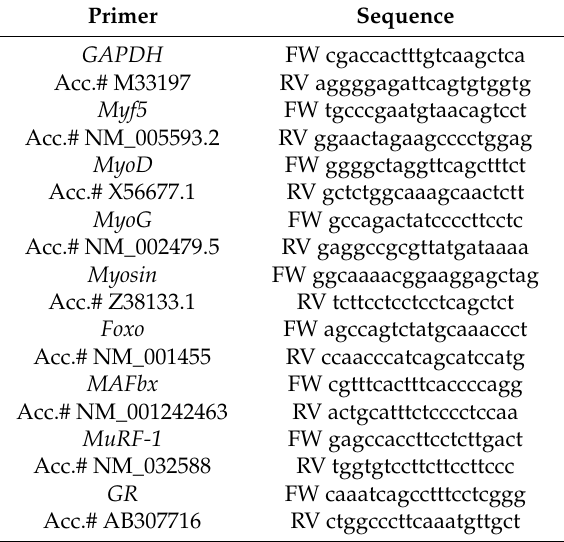
Table 2. Primer pairs for human myoblasts (Eurofins Genomics, Ebersberg, Germany). Primer